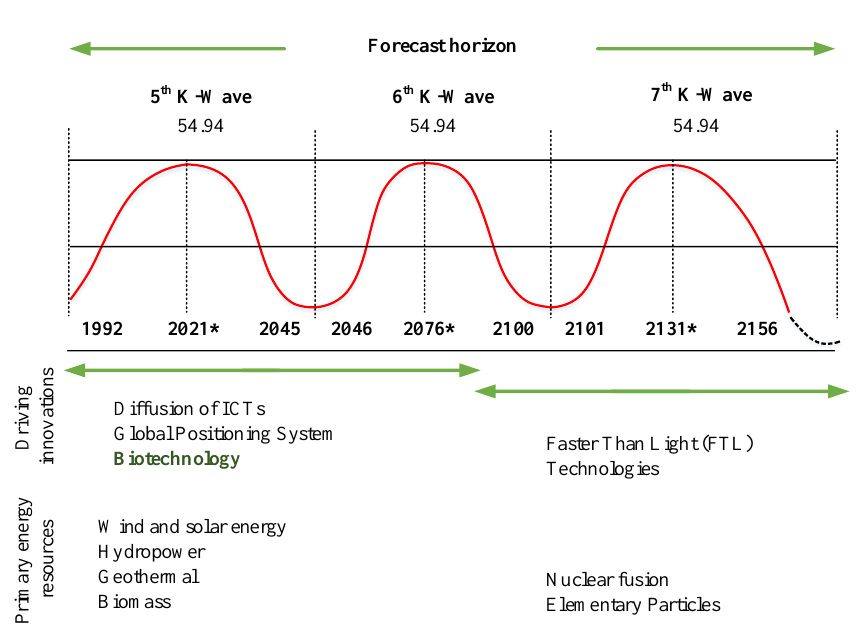
Fig. 4. Forecast of long waves, their driving technological innovations and primary energy resources [26],